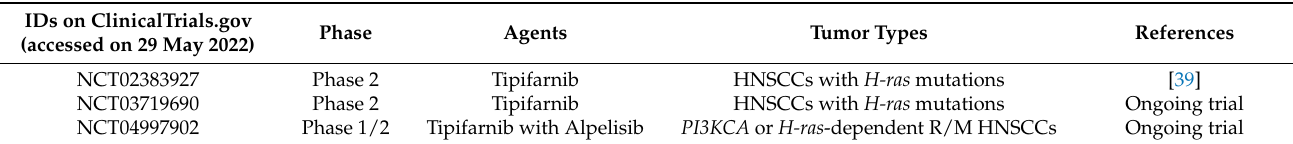
Table 2. List of clinical trials of FTIs against HNSCCs R/M, recurrent or metastatic. IDs on ClinicalTrials.gov (accessed on 29 May